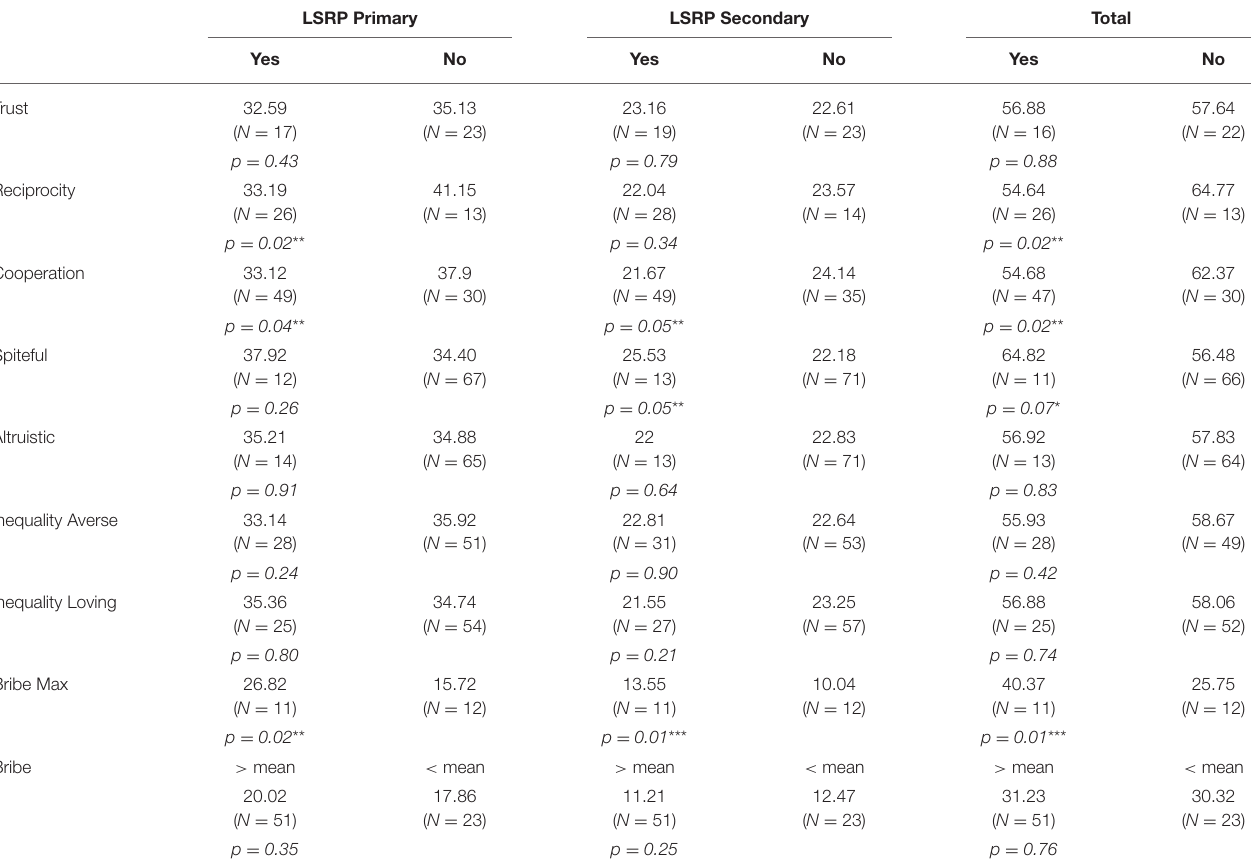
TABLE 4 | Social behavior and